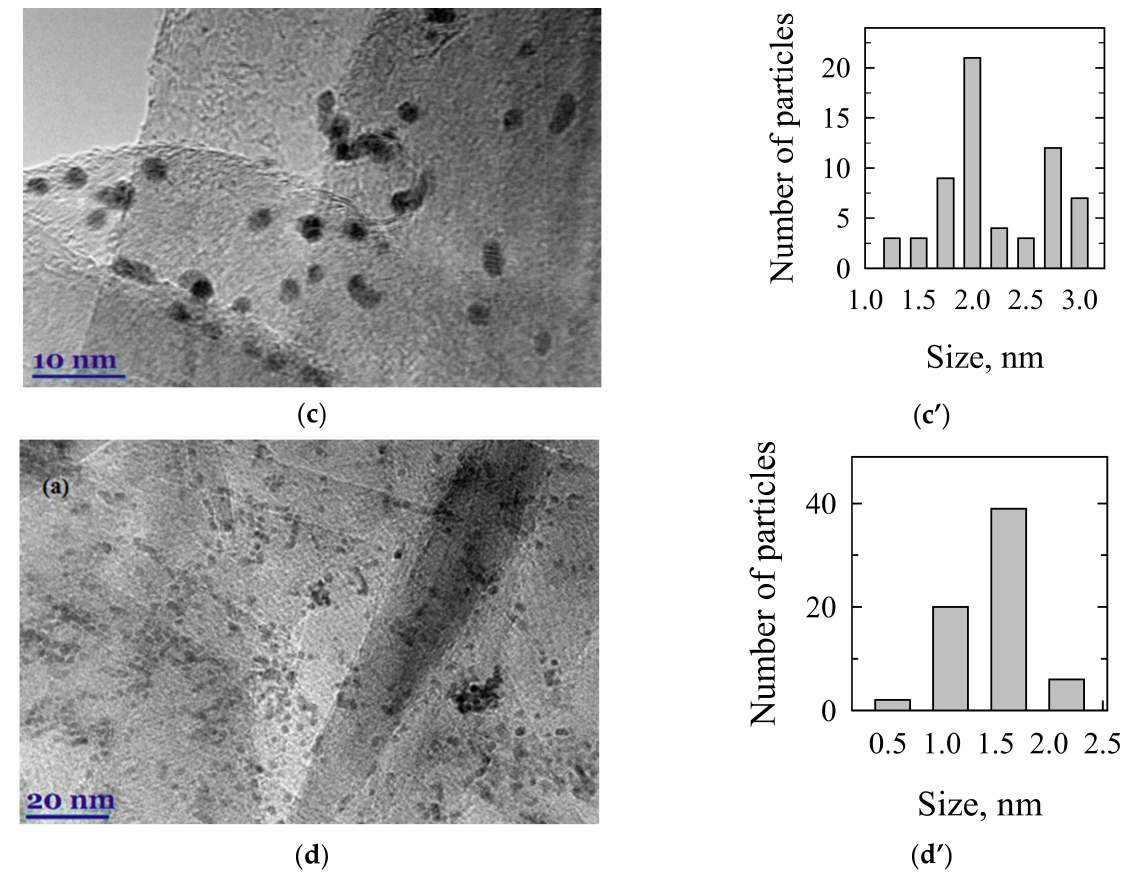
Figure 2. TEM images and the corresponding particle size distribution of PtCoMn(1:3:1)/GR ( a , a’ ), PtCoRu(1:2:2)/GR ( b , b’ ), PtCoMo(7:2:1)/GR ( c , c’ ), and Pt/GR ( d , d’ ) catalysts.